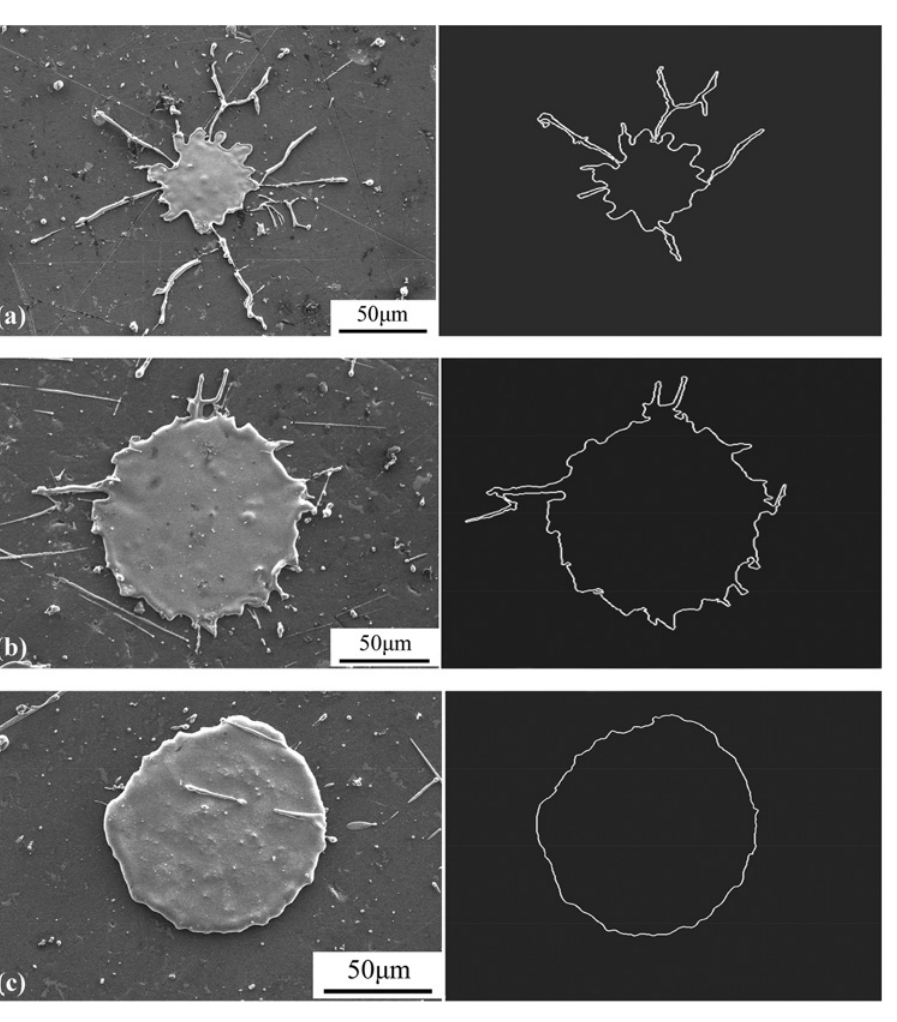
Figure 3: Typical splat deposited on the substrate preheated to (a) 25 ± 2°C, (b) 150 ± 8°C and (c) 250 ± 10°C. The left micrographs are FESEM images and the right micrographs are the corresponding images after Canny algorithm edge detection.